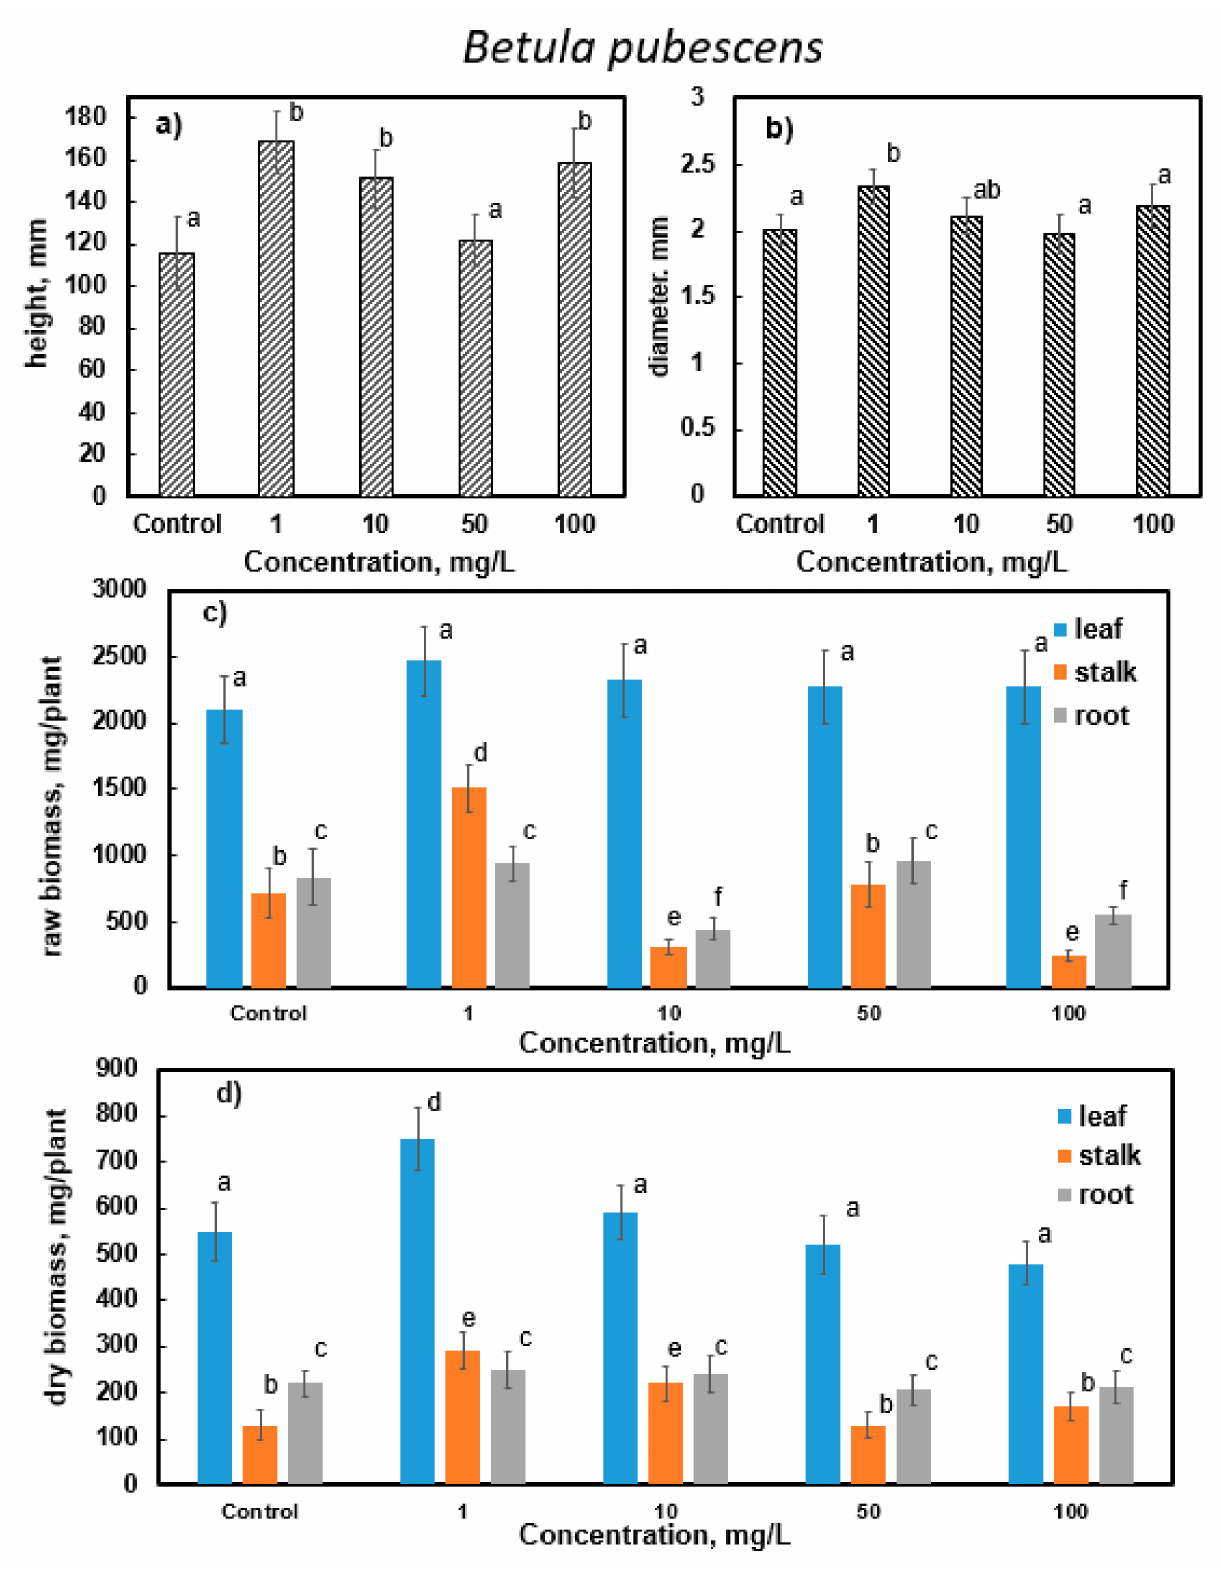
Figure 5. Effect of MWCNTs on height ( a ), diameter ( b ), parameters of wet ( c ) and dry ( d ) biomass of downy birch ( B. pubescens ) plants. Bars represent the ± SE of three replicates. Letters on vertical bars represent significant differences between groups according to Duncan’s multiple range test at p <